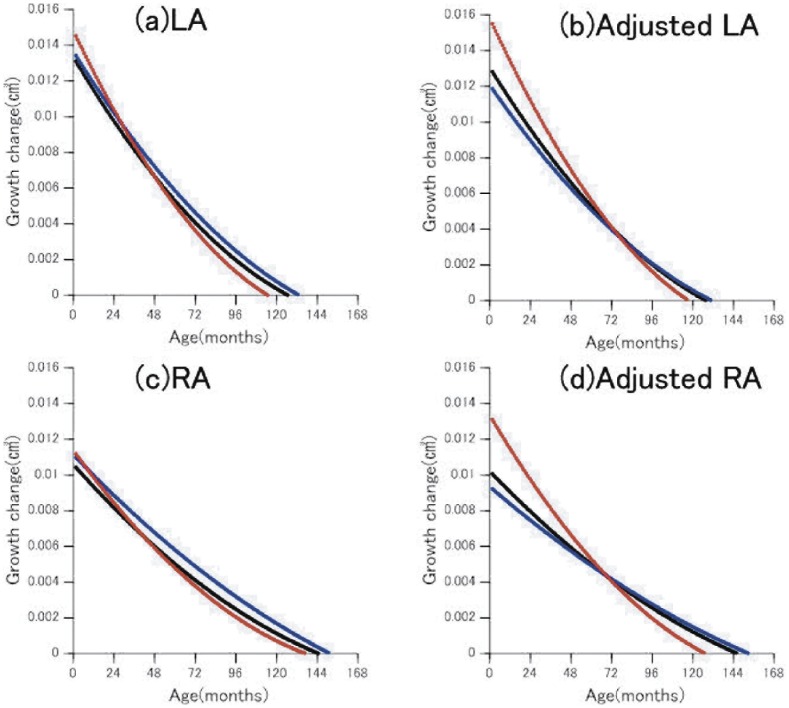
Rate of growth change in amygdalar volumes.(a); LA: left amygdala, (b);left amygdala adjusted by ICV, (c); RA: right amygdala, (d);right amygdala adjusted by ICV. The rates of monthly volume changes in the right and left amygdala. Positive values indicate increasing volume. The point of intersection on the x-axis represents the age of local maximal volume. Black line: whole group, blue line: males, red line: females.